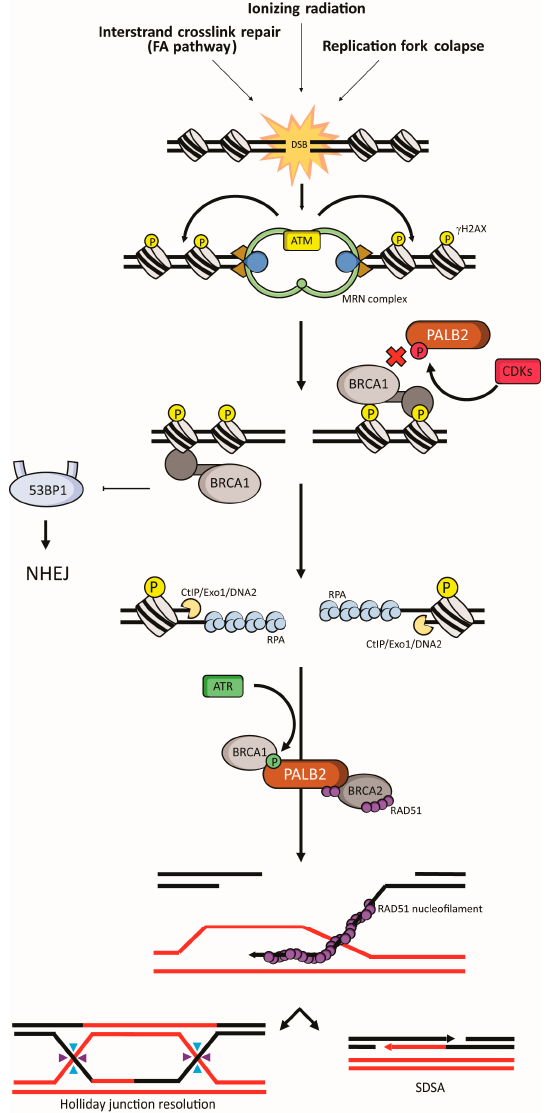
Figure 2. The role of PALB2 in the DNA damage repair. Schematic representation of double strand break (DSB) induction and resolution throughout the HR repair pathway. Double strand breaks can result from different sources (as a by-product of the FA pathway, ionizing radiation treatment or replication fork collapse in response to replicative stress). After the DSB is induced, the MRN (MRE11-RAD50-NBS1) sensor complex recognizes and binds this structure. ATM is then recruited and activated, leading to the phosphorylation of H2AX ( γ H2AX), amplifying the initial signaling. The signal transduction leads to BRCA1 recruitment to the DNA damaged site, driving the HR repair by inhibition of 53BP1 and consequently the Non Homologous End-joining (NHEJ) pathway. At this point, PALB2 is found phosphorylated (pS64; in red) by Cyclin-dependent Kinases (CDKs), which prevents its interaction with BRCA1. Then, the 5 ′ DNA end resection is performed by C-terminal binding protein (CtBP) Interacting protein (CtIP), Exonuclease 1 (Exo1) and DNA2 exonuclease activities. The replication protein A (RPA) caps the exposed ssDNA, culminating in the activation of ATR and PALB2 (pS59; in green), which favors PALB2-BRCA1 interaction (in contrast with pS64). Thus, BRCA1 recruits PALB2, BRCA2 and RAD51, promoting exchange of RPA by RAD51, nucleofilament formation and strand invasion. Later, the repaired DNA is resolved in a Holliday junction-mediated (light blue and purple arrowheads represent the crossover and non-crossover resolution types, respectively) or by synthesis dependent strand annealing-dependent (SDSA) manner.